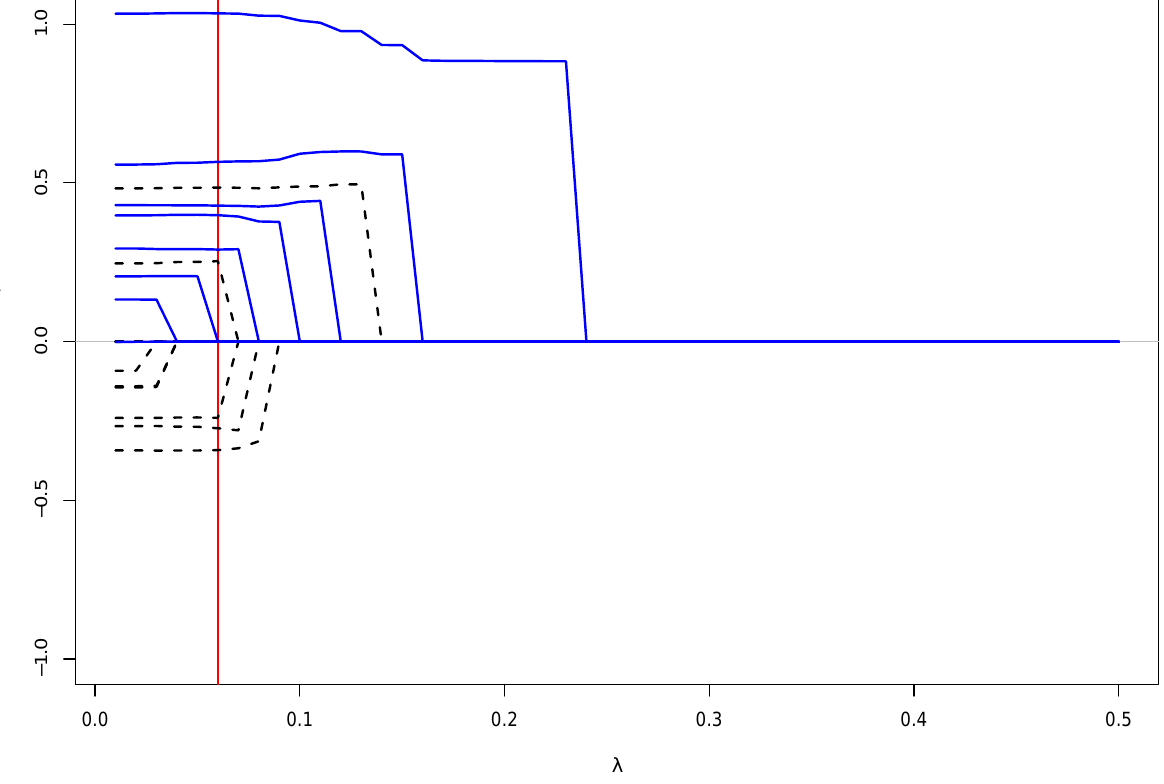
Figure 6. Simulated Case Study 2: DIF effects e i as a function of the regularization parameter λ . Regularization paths for DIF effects are printed in blue solid lines, while paths for non-DIF effects are shown in black dashed